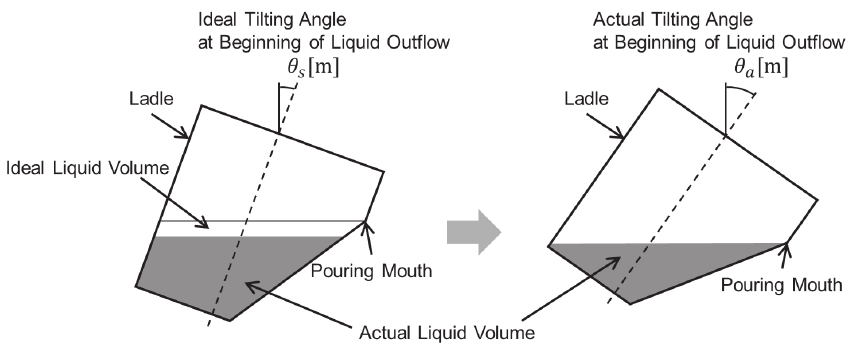
Figure 12. Tilting angle of ladle at the start of liquid outflow.